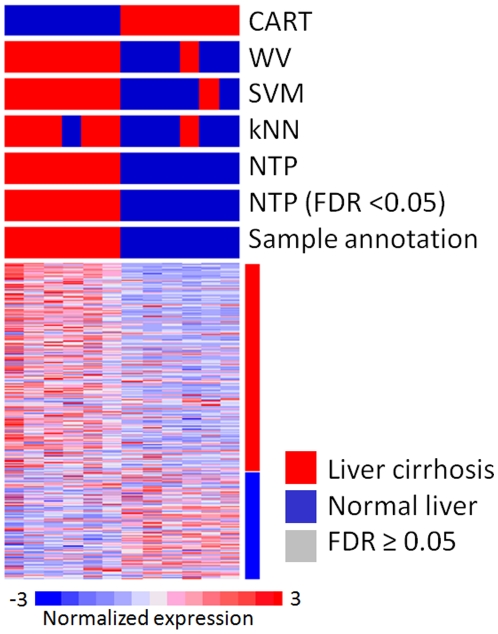
Example 3: Cross-species prediction of liver cirrhosis between human and rat.Human liver cirrhosis signature generated by comparing 13 cirrhotic and 10 normal livers was tested on rat livers with or without liver cirrhosis induced by bile duct ligation.